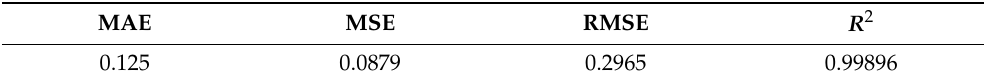
Table 1. Metrics of model.